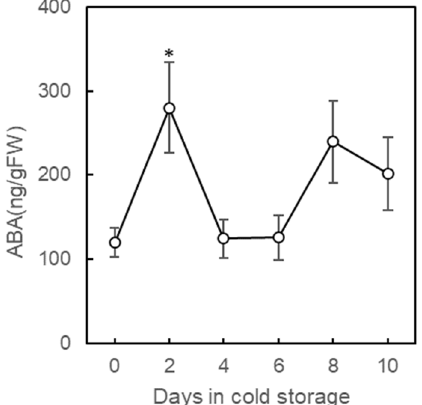
Figure 6. Changes in abscisic acid (ABA) contents of strawberry fruits during cold storage at 0 °C for 10 days. Harvested strawberry fruits were stored at 0 °C for 10 days with porous film bag. The vertical bar indicates a standard error of six replicates. Asterisks indicate significant differences in comparison to control (0 day) at p = 0.05 * with Wilcoxon test.